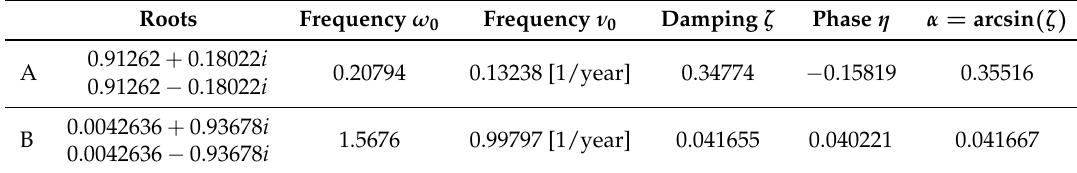
Table 2. Approximation with pure AR(2)-components. The frequency is also given as ordinary frequency ν 0 . The variance of the combined covariance function amounts to σ 2 = 0.02046mm 2 which leads to σ N = 0.04359mm. ω 0 and η are given in units of radians.